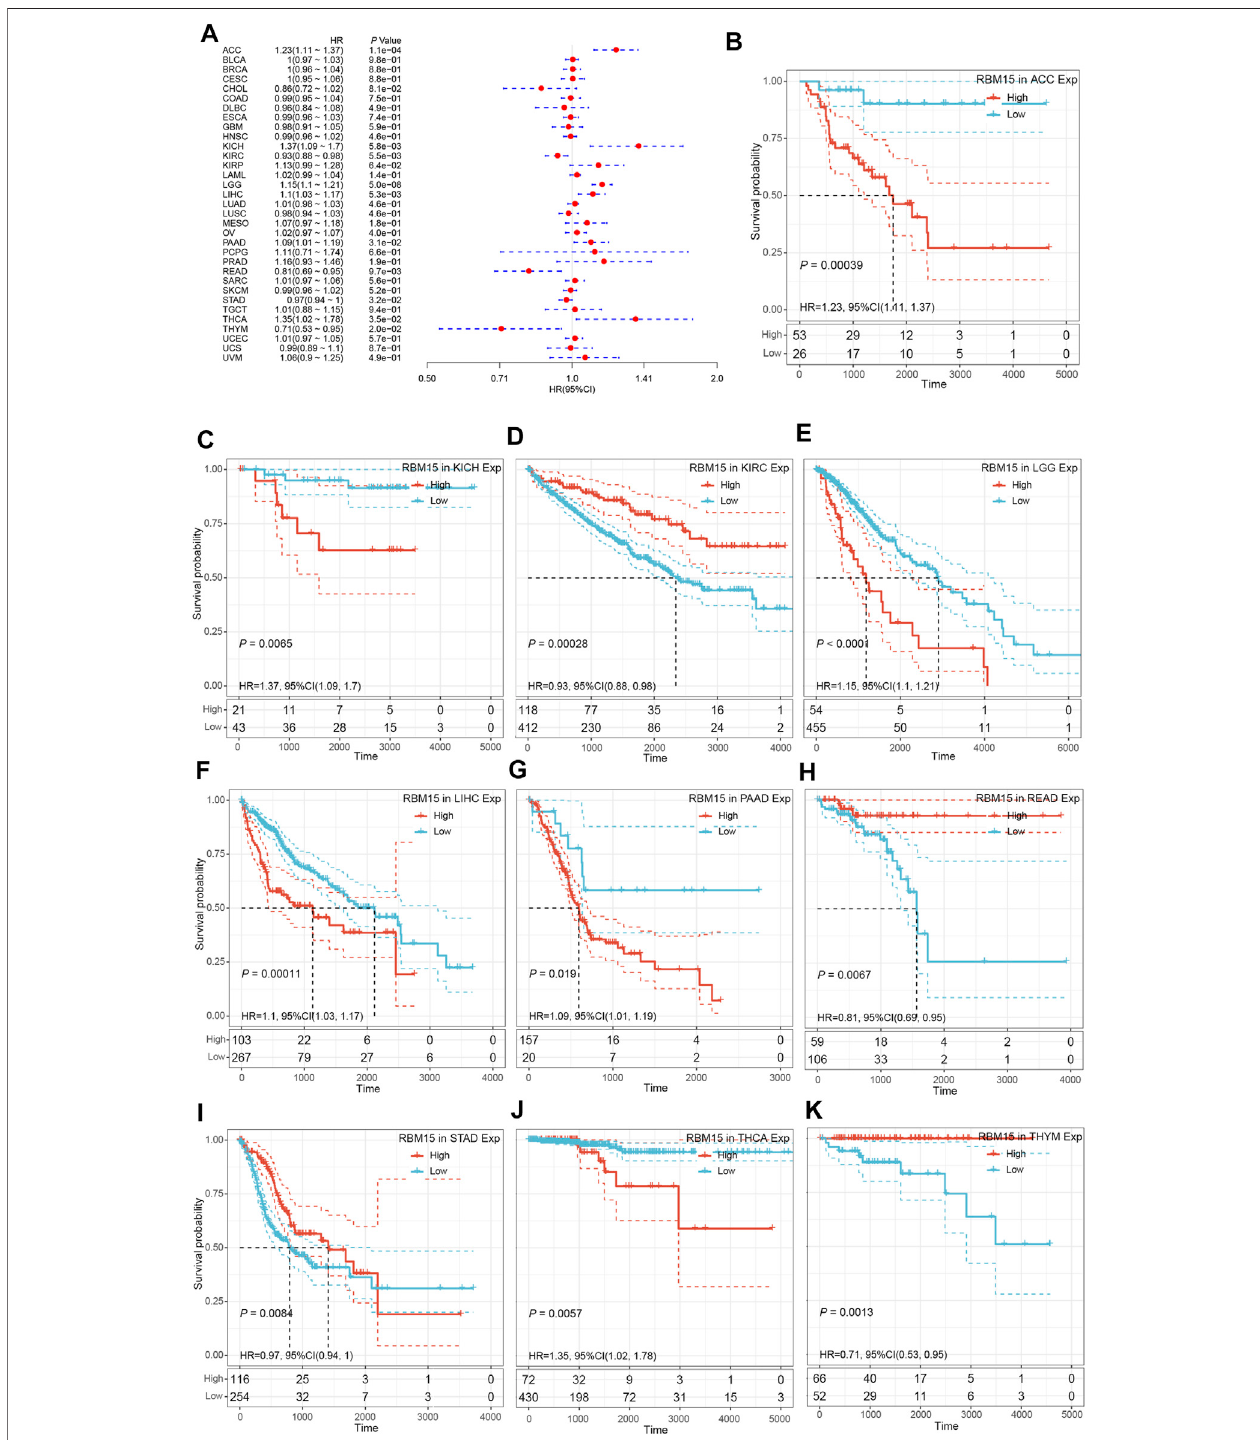
FIGURE 3 | RBM15 expression is correlated with patient ’ OS. (A) Forest plots of HR for RBM15 expression in 33 tumor types. (B – K) Kaplan-Meier curves of signi fi cant correlation between RBM15 expression levels and patient ’ OS in ACC, KICH, KIRC, LGG, LIHC, PAAD, READ, STAD, THCA and THYM.